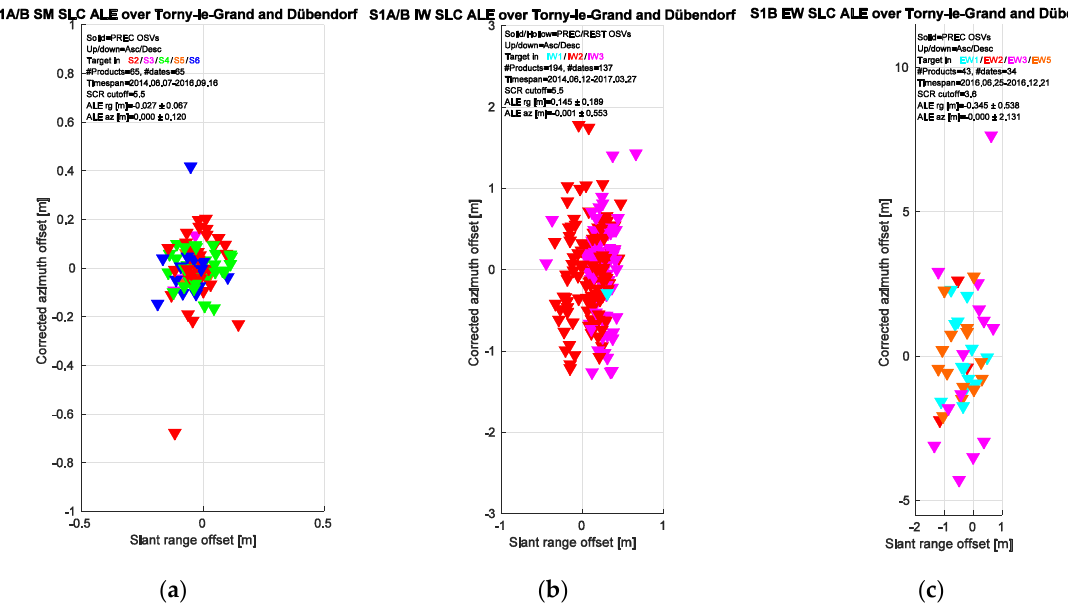
Figure 8. ALE scatterplots of SLC product time series after proposed beam-dependent azimuth correction ( a ) SM SLC; ( b ) IW SLC; ( c ) EW SLC. Compare with uncorrected plots in Figures 3c, 4c and 5a. Table 3. Azimuth offsets (and associated precision) measured for individual beams or subswaths.